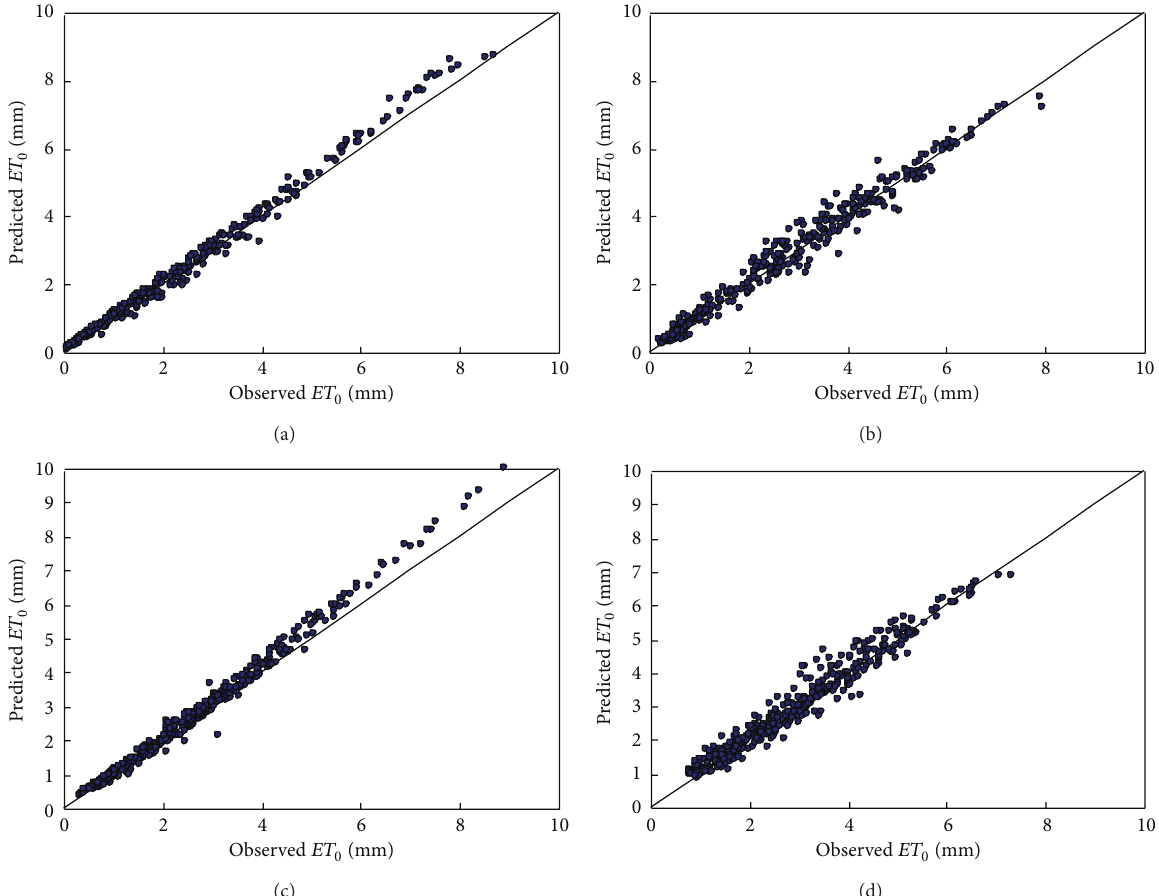
Figure 8: Scatter plot of daily 𝐸𝑇 0 series forecasted by chaotic model and that computed with observed weather variables: (a) Baotou station; (b) Zhangbei station; (c) Kaifeng station; (d) Shaoguan